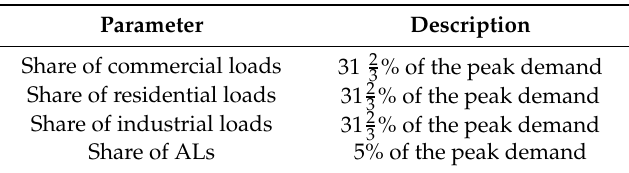
Table 1. Parameters of the model—demand.